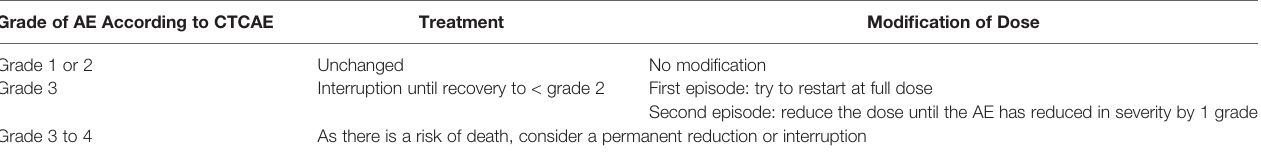
TABLE 2 | General algorithm for dose interruptions and reductions according to the severity of apatinib-associated adverse events. Grade of AE According to